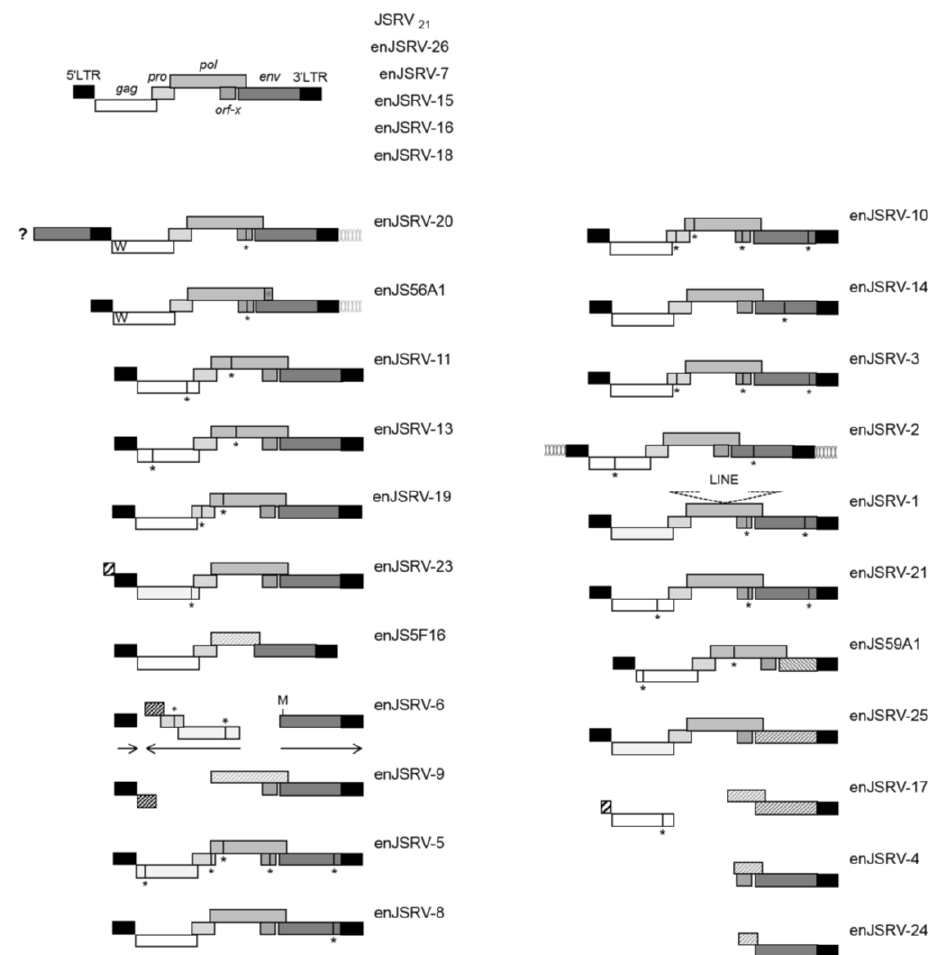
Figure 2. Genetic organization of enJSRV proviruses. All the genomic sequences flanking enJSRV proviruses display a six base pair duplication that is the hallmark of retroviral integration. The only exceptions are enJSRV-20, which contains a portion of an env gene before the 5' LTR (indicated by a dark grey box and ? mark), and enJSRV-2 that does not possess the same six base pairs sequences flanking its LTRs. At the top are shown the five enJSRVs displaying an intact genomic organization, typical of replication competent exogenous retroviruses. The two transdominant proviruses enJS56A1 and enJSRV-20 possess a tryptophan residue (W) at position 21 of Gag and identical 3' genomic flanking regions. The enJSRV-6 locus contains an additional methionine (M) in Env besides the canonical start codon present in JSRV and other enJSRV loci. In addition, in enJSRV-6, gag and pro are oriented in opposite direction compared to the 5' LTR, 3' LTR and env (indicated by horizontal arrows). enJSRV-1 possesses a long interspersed nucleotide element (LINE) within the pol coding region. Note that the following enJSRVs are insertionally polymorphic in the genome of domestic sheep: enJSRV-7, enJSRV-8, enJSRV-15, enJSRV-16, enJSRV-18, enJSRV-26 and enJS5F16. Premature termination codons are represented by a vertical line and an asterisk ( * ). Large deletions in proviral genomes are indicated by hatched boxes. enJSRV, endogenous Jaagsiekte sheep retrovirus; LTR, long terminal repeat (Figure modified from Arnaud et al . 2007 PLoS Pathogens)